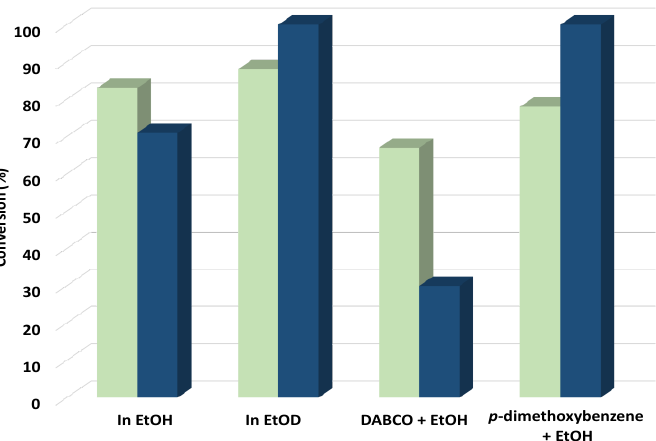
Figure 6. Recyclability of the PTH-material, with yields to each product, sulfoxide (purple) and sul- fone (yellow) derived from oxidation of dibutylsulfide. Figure 7. Mechanistic experiments for oxidation of dibutylsulfide (green) and p-methylthioanisol (blue) substrates using PTH-polymer as photocatalytic material.